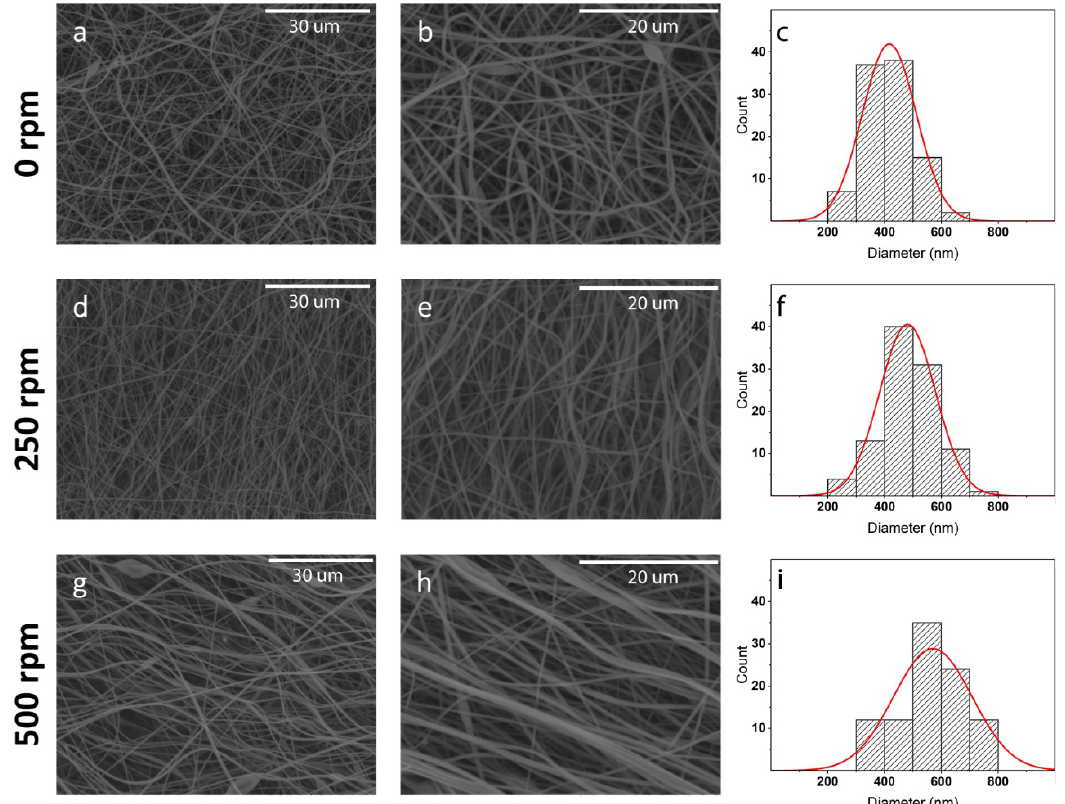
Figure 1. The morphology at low ( a , d and g ) and high ( b , e , and h ) magnification for PVP membranes obtained with a collector rotation speed of 0 rpm ( a and b ), 250 rpm ( d and e ), and 500 rpm ( g and h ). Size histograms ( c , f and i ) of the obtained nanofibers are given.